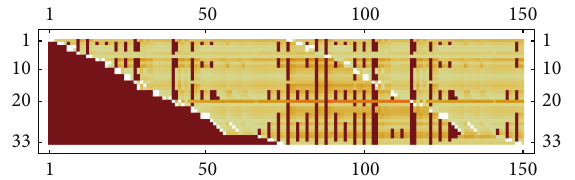
Figure 4: The cost matrix for our data. Dark is high and low is light.